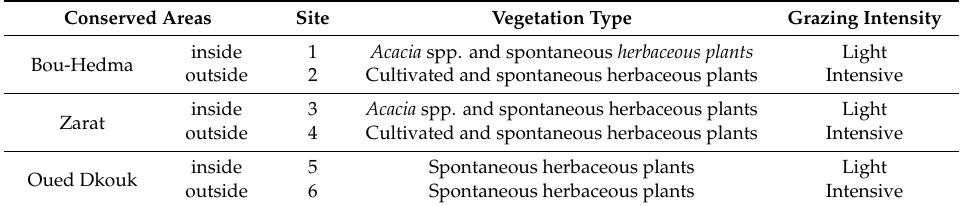
Table 1. Details of the six sampling sites at the three conserved natural areas.